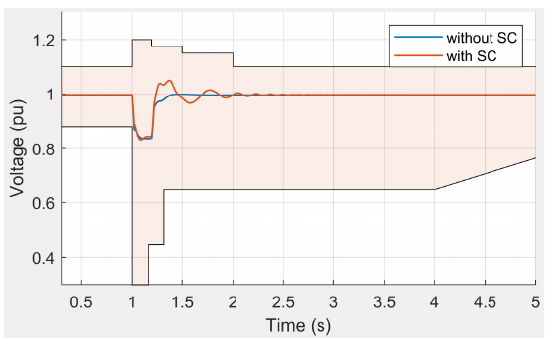
Figure 8. Voltage response comparison during a fault